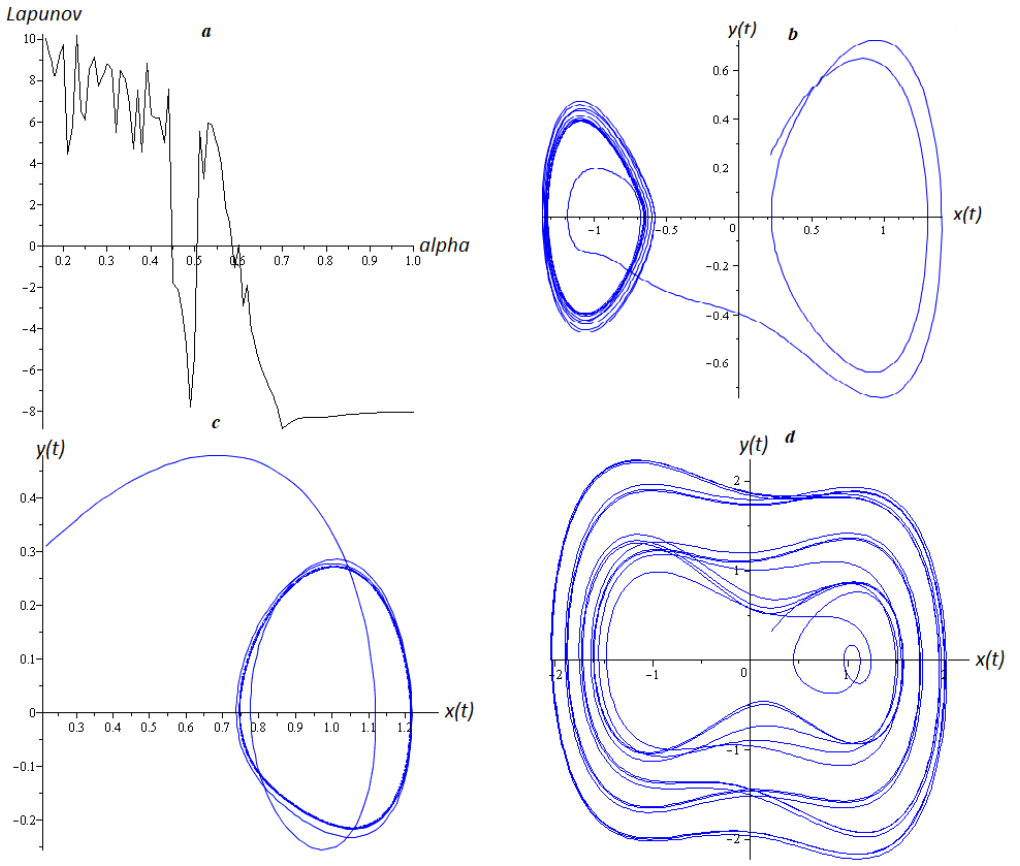
Figure 2. Range of Lyapunov exponents from λ ( a ) and phase trajectories at ( b ) λ = 0.47, ( c ) λ = 0.64 and ( d ) λ =